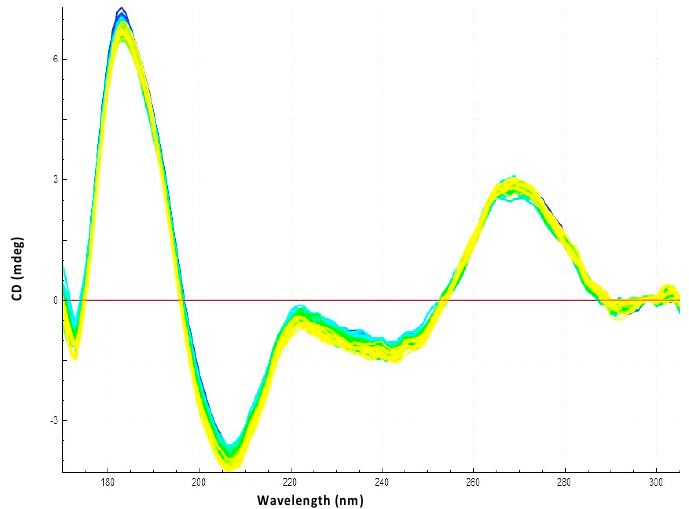
Figure 7. Observation of the effect of Hfq-CTR on rpoS reg : rpoS rbs stability using SRCD (from blue t = 0 min to yellow t = 300 min). No significant stabilization is observed.